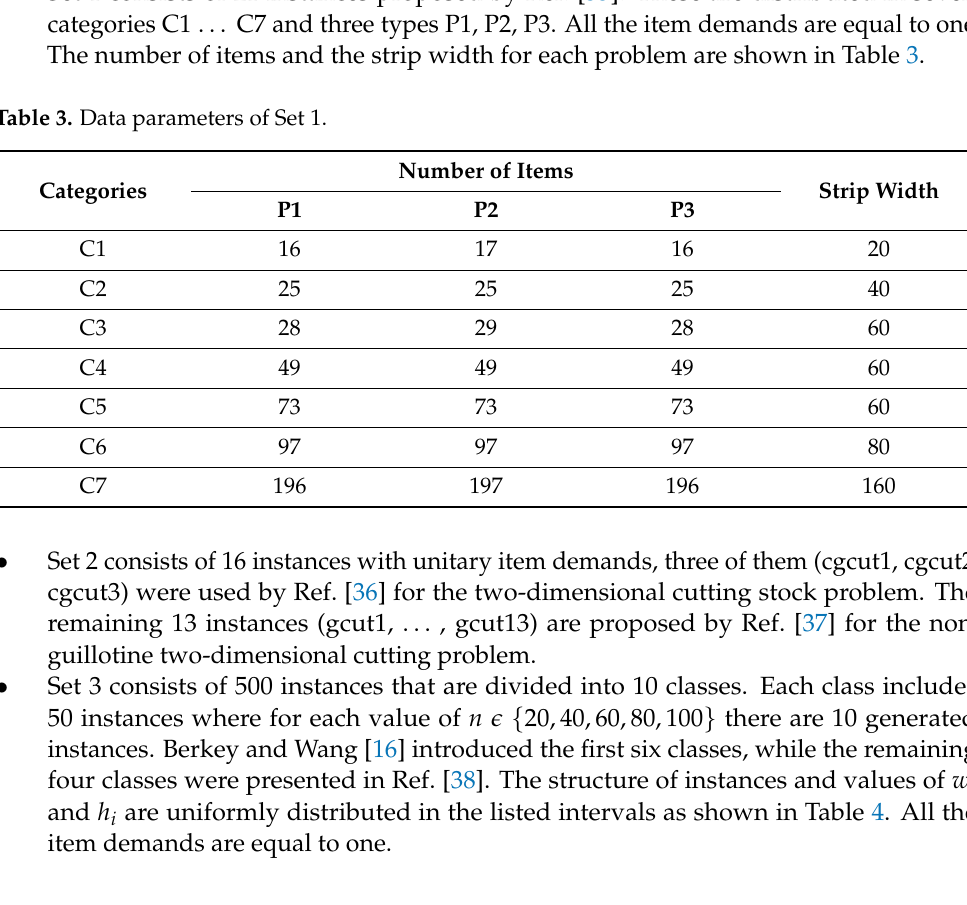
Figure 8. The three graphs of shelf 2.